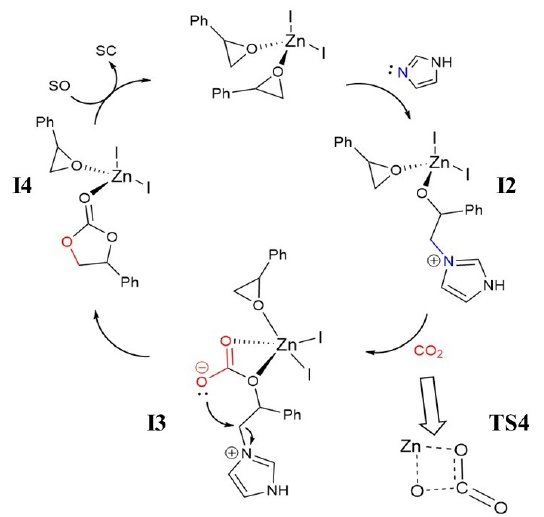
SO into SC (Scheme 3). The first step being the attack of the imidazole on the epoxide, opening the epoxide and forming Intermediate 2 (I2). In the following step, the CO 2 inserts itself via a four-membered cycle transition state (TS4). This leads to a penta-coordinated trigonal bipyramidal intermediate (I3). After that, ring closing occurs in an SN 2 type mech- anism where the free oxygen acts as a nucleophile and the Imidazolium as the leaving group leading to Intermediate 4 (I4). The final step is the substitution of the newly formed SC by a SO to regenerate the catalyst.